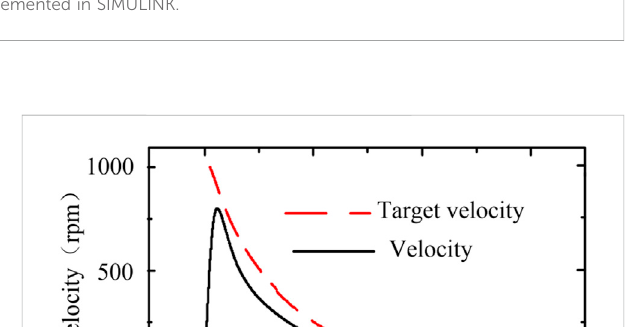
FIGURE 4 The block diagram of collaborative control system for co-simulation implemented in SIMULINK.